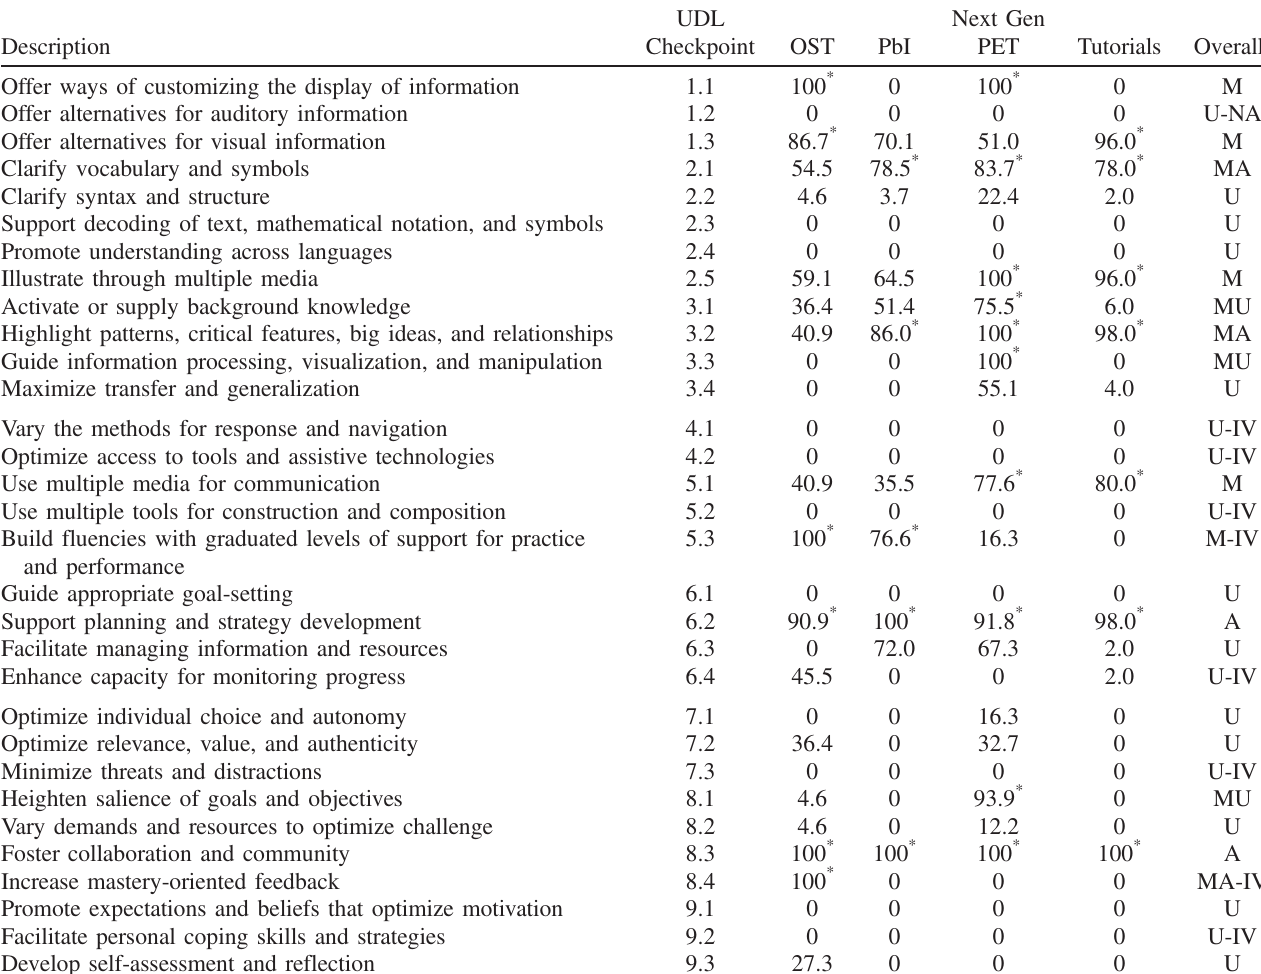
* Indicates alignment (at least 75% of activities aligned) between UDL checkpoint and specific physics curriculum. a In the overall alignment column, U represents unaligned (none of the curricula aligned), MU represents mostly unaligned (1 curriculum aligned), M represents mixed alignment (2 curricula aligned), MA represents mostly aligned (3 curricula aligned), and A represents aligned (all 4 curricula aligned). The letters represent the source of the unalignments (IV represents unalignment due to implementation variability and NA represents unalignment due to